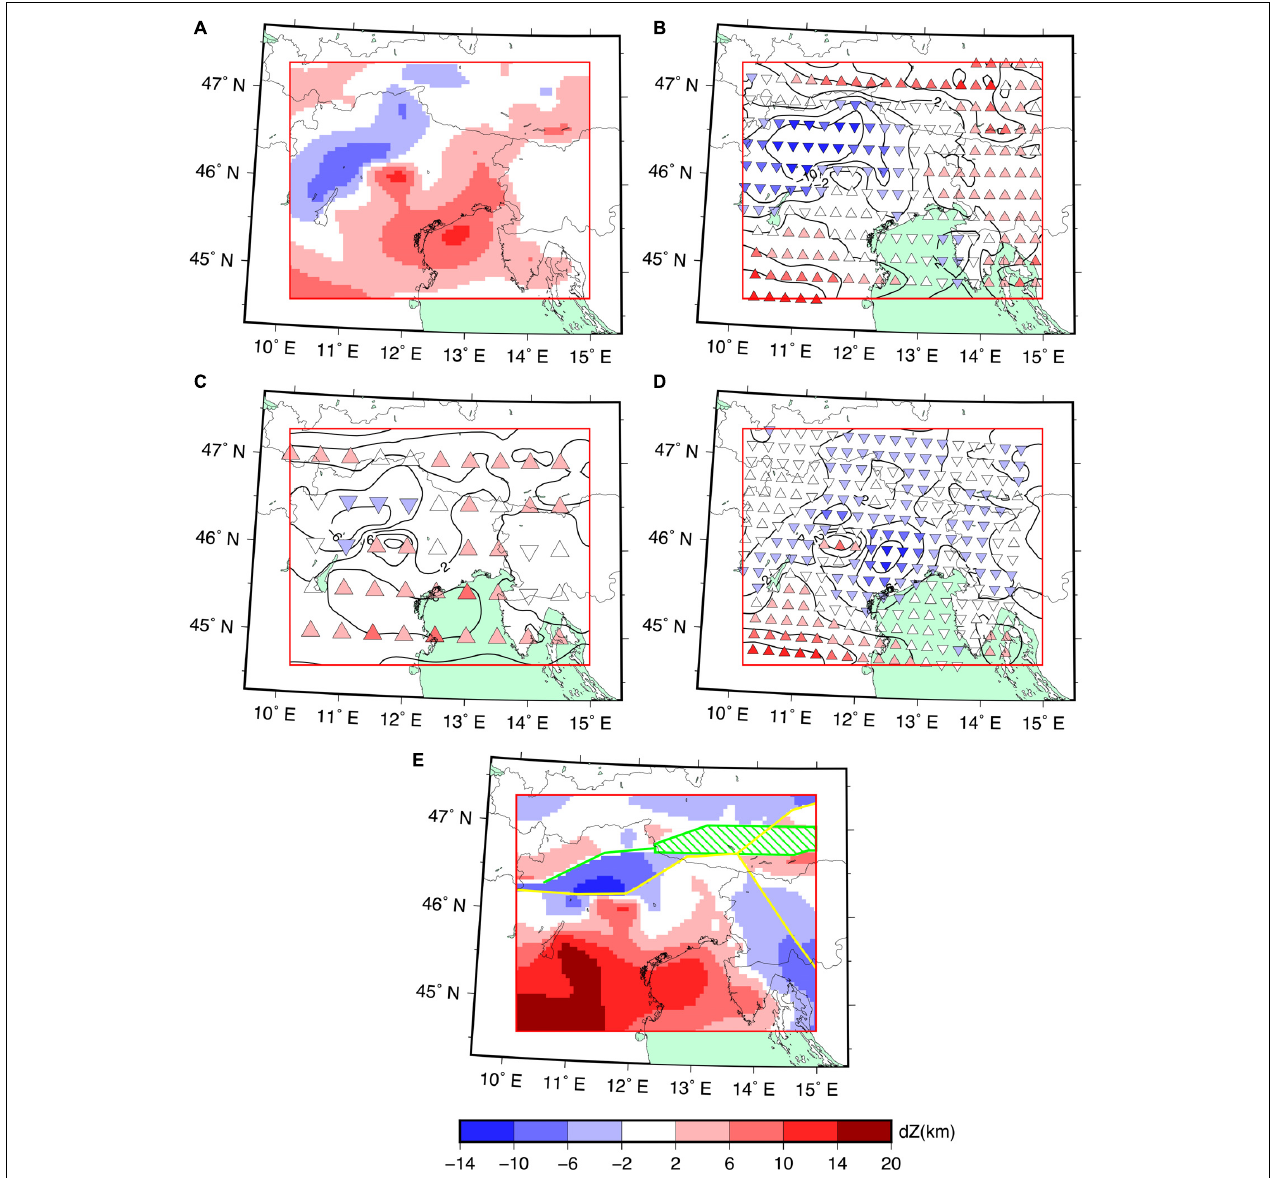
FIGURE 12 | Differences between (A) Moho of Grad et al. (2009b) and MO1; (B) Moho of EuCRUST-07 and MO1; (C) Moho of EPCrust and MO1; (D) Moho of Spooner et al. (2019) and MO1; (E) Moho of Spada et al. (2013) and MO2. The triangles in (B–D) show the differences computed on the coarser grid and the isolines are computed from the differences on the finer grid (see text for details). The yellow lines in (E) show the boundaries between the fragments of MO2, the green lines the boundaries between the fragments of the Moho according to Spada et al. (2013) and the area filled by green lines is where Spada et al. (2013) did not define a Moho